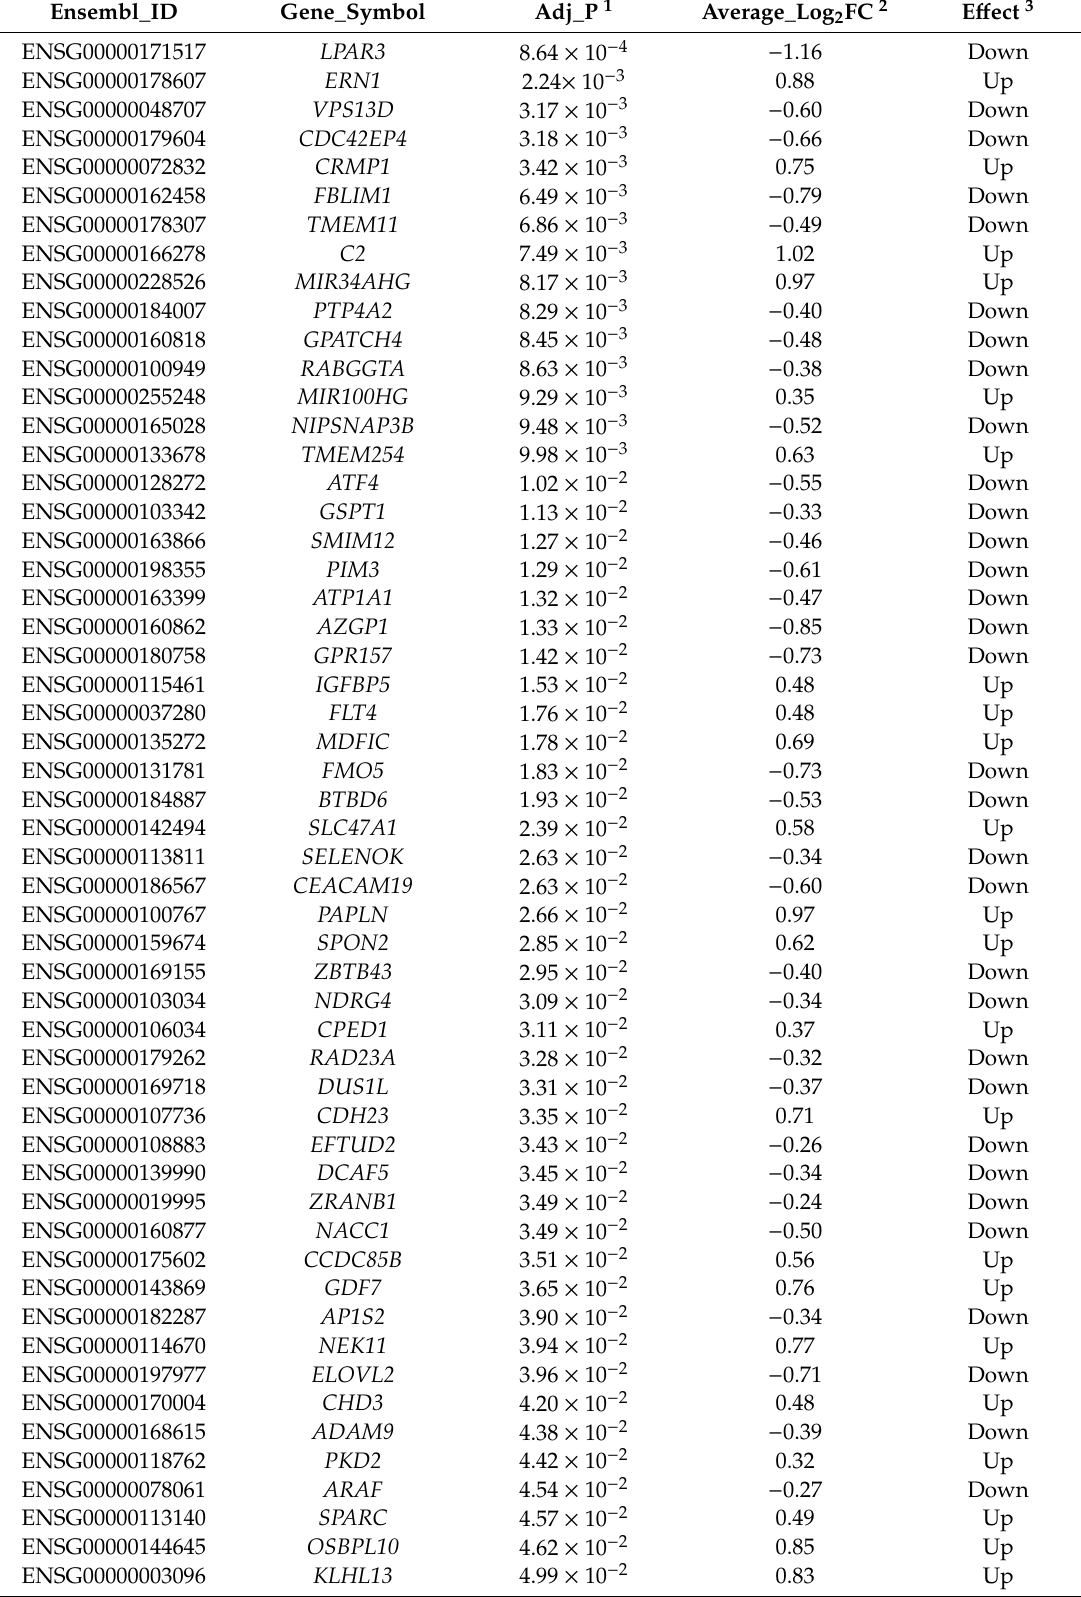
Table 3. DEGs identified only by